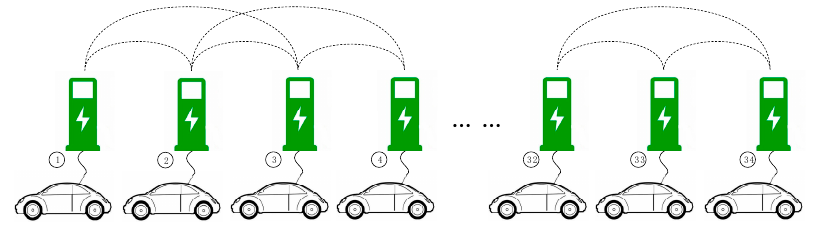
Figure 6. Topology of the EV charging piles.